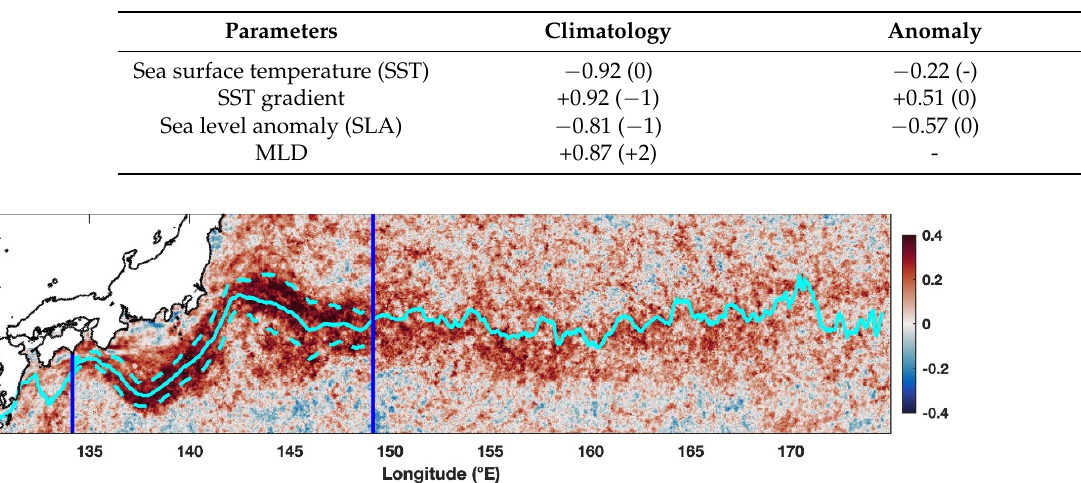
Figure 6. Correlation between the time series of the SST gradient and Chl-a in the anomalous field. The correlation is significant at the 95% confidence level if the critical value is greater than and less than 0.28 and − 0.28, respectively. The solid (dashed) cyan line represents the location of the center (boundary) of the region with a large correlation, > 0.28, in the meridional direction. The boundary is defined as the range within one standard deviation of the meridional variation from the center. The solid blue lines represent the averaged boundary of the region with a significant correlation in the zonal direction. The region with a significant correlation is used to obtain Figures 7–9 and Table 1.